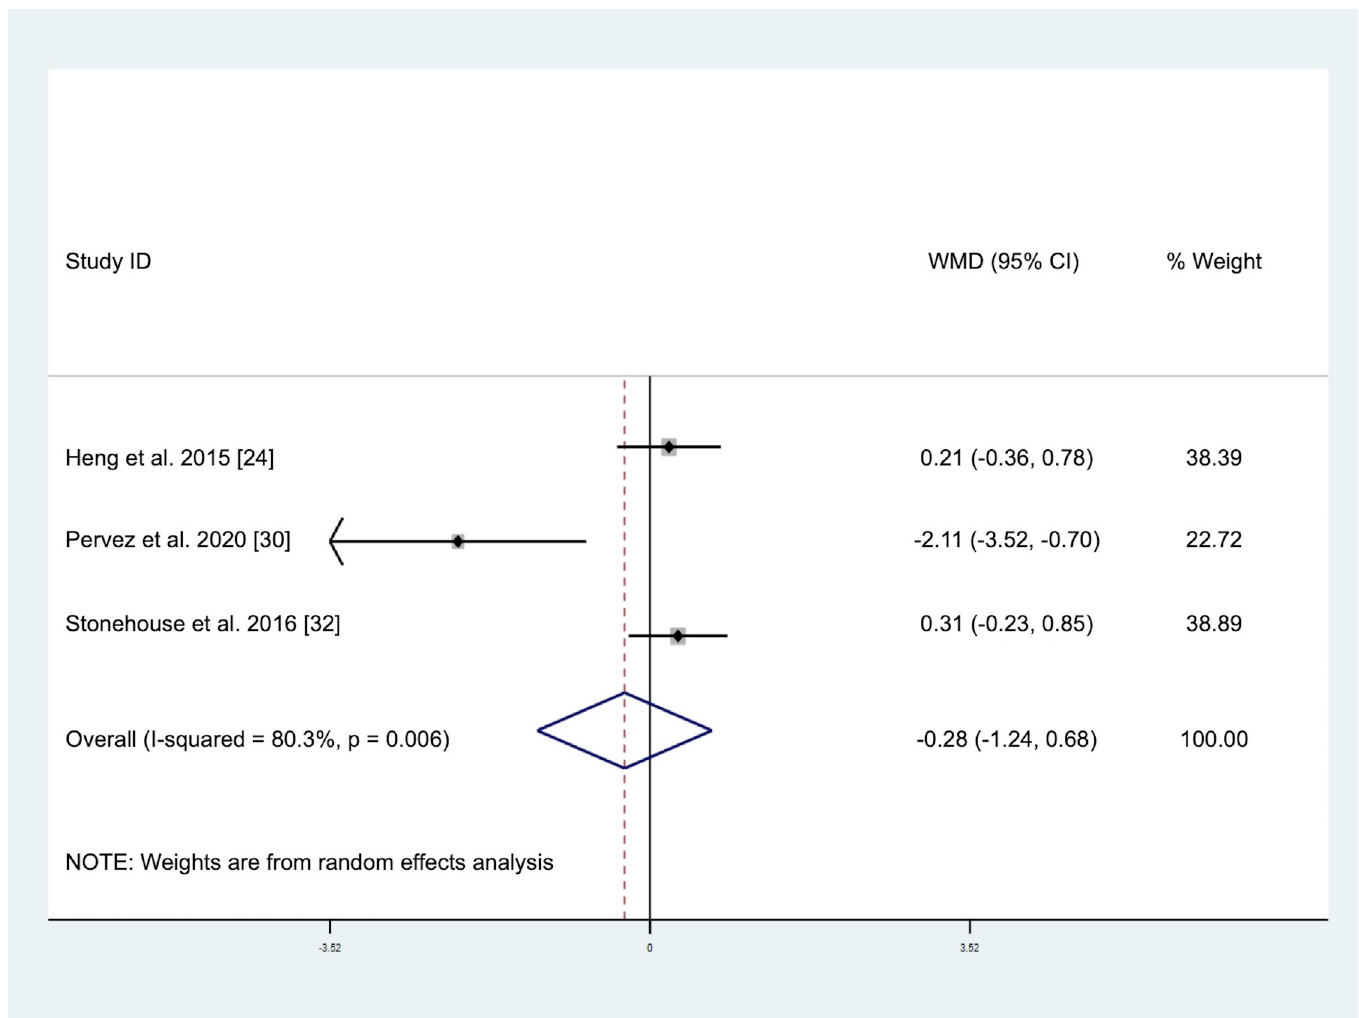
Fig 4. Forrest plot on the effect of tocotrienols supplementation on tumor necrosis factor-alpha levels.